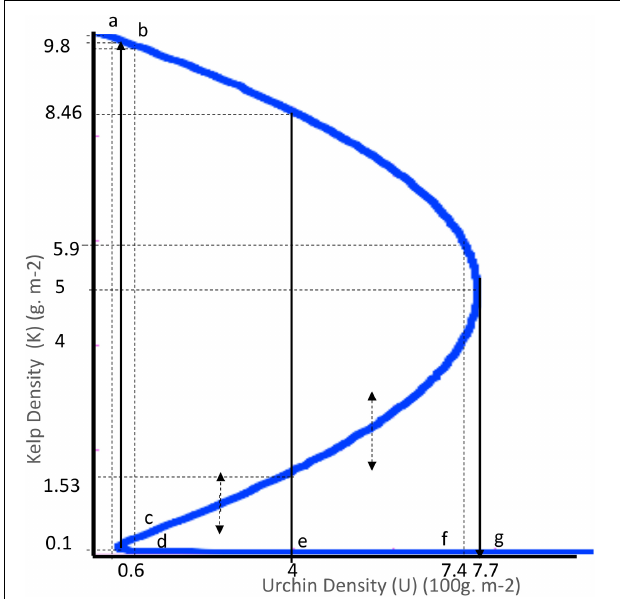
FIGURE 1 | Urchin-kelp subsystem isocline: The cubic equation for the ˙ K = 0 isocline is K 3 − 10 K 2 + ( 0 . 01 + 3 . 25 U ) K − 0 . 1 = 0. Arrows indicate movement away from equilibria on the unstable arm and toward equilibria on the stable arms. The ( U , K ) coordinates for the letters are: a − ( 0 . 4 , 9 . 9 ) , b − ( 0 . 7 , 9 . 7 ) , c − ( 0 . 7 , 0 . 17 ) , d − ( 0 . 7 , 0 . 06 ) , e − ( 4 , 0 . 008 ) , f − ( 7 . 4 , 0 . 004 ) , and g − ( 7 . 7 , 0 . 004 )